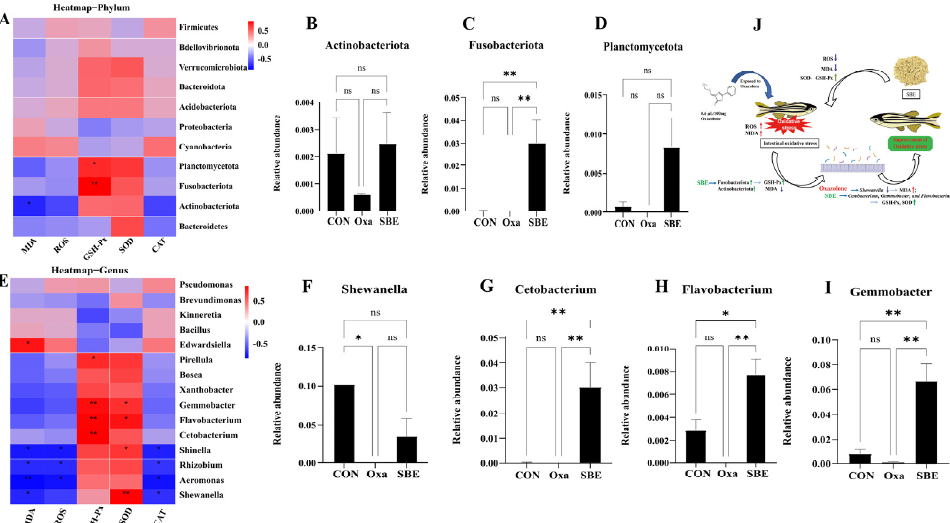
Figure 6. The correlation analysis between the contents of oxidative stress biomarkers and intestinal flora. The variation of oxidative stress biomarkers with relation to the intestinal microbiota. Correlation between biomarkers and intestinal microbiota at the phylum level ( A ). Histogram about the abundance of microbe that correlated with biomarkers contents at the phylum level ( B − D ). Correlation between biomarkers and intestinal microbiota at the genus level ( E ). Histogram about the abundance of microbe that correlated with biomarkers contents at the genus level ( F − I ). Mechanistic diagram of SBE regulating oxidative stress biomarkers via intestinal flora in zebrafish ( J ). A redder color indicates a positive correlation, while a bluer color indicates a negative correlation (* p < 0.05, ** p < 0.01. n ≥ 3/per group).